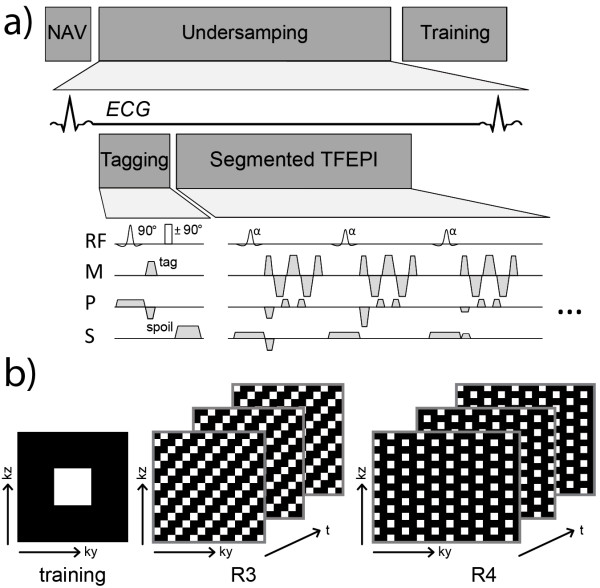
Sequence diagram (a) and sampling pattern for k-t undersampling (b). After detection of the R-wave the tagging preparation is applied, followed by two repetitions of undersampled data and training data acquisitions for each stack.